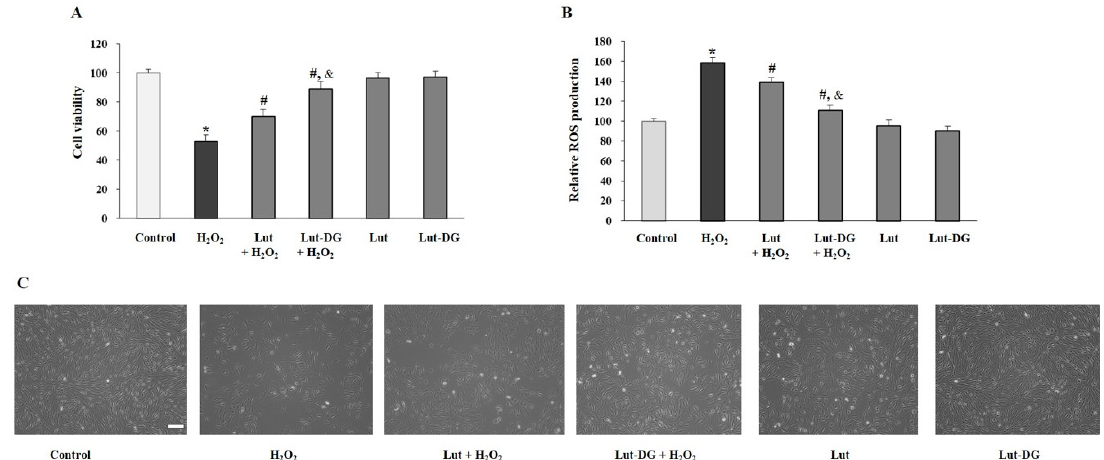
Figure 4. Protective effects of Lut and Lut-DG on H 2 O 2 -induced cytotoxicity and ROS production in ARPE-19 cells. ( A ) ARPE-19 cells were pre-treated with 1 µM of Lut and Lut-DG for 24 h, followed by H 2 O 2 treatment at 400 µM 1 h. Cell viability was measured using MTT assay; ( B ) ROS generation was determined by DCFH-DA assay. Graphs represent average cell viability and ROS production (mean ± SD values, n = 4; (One-Way ANOVA test), * p ≤ 0.05 vs. control group, # p ≤ 0.05 vs. H 2 O 2 group, and & p ≤ 0.05 vs. Lut + H 2 O 2 group); ( C ) Morphology by phase-contrast microscopy of ARPE-19 cells under all experimental conditions. Scale bar represents 100 µm.